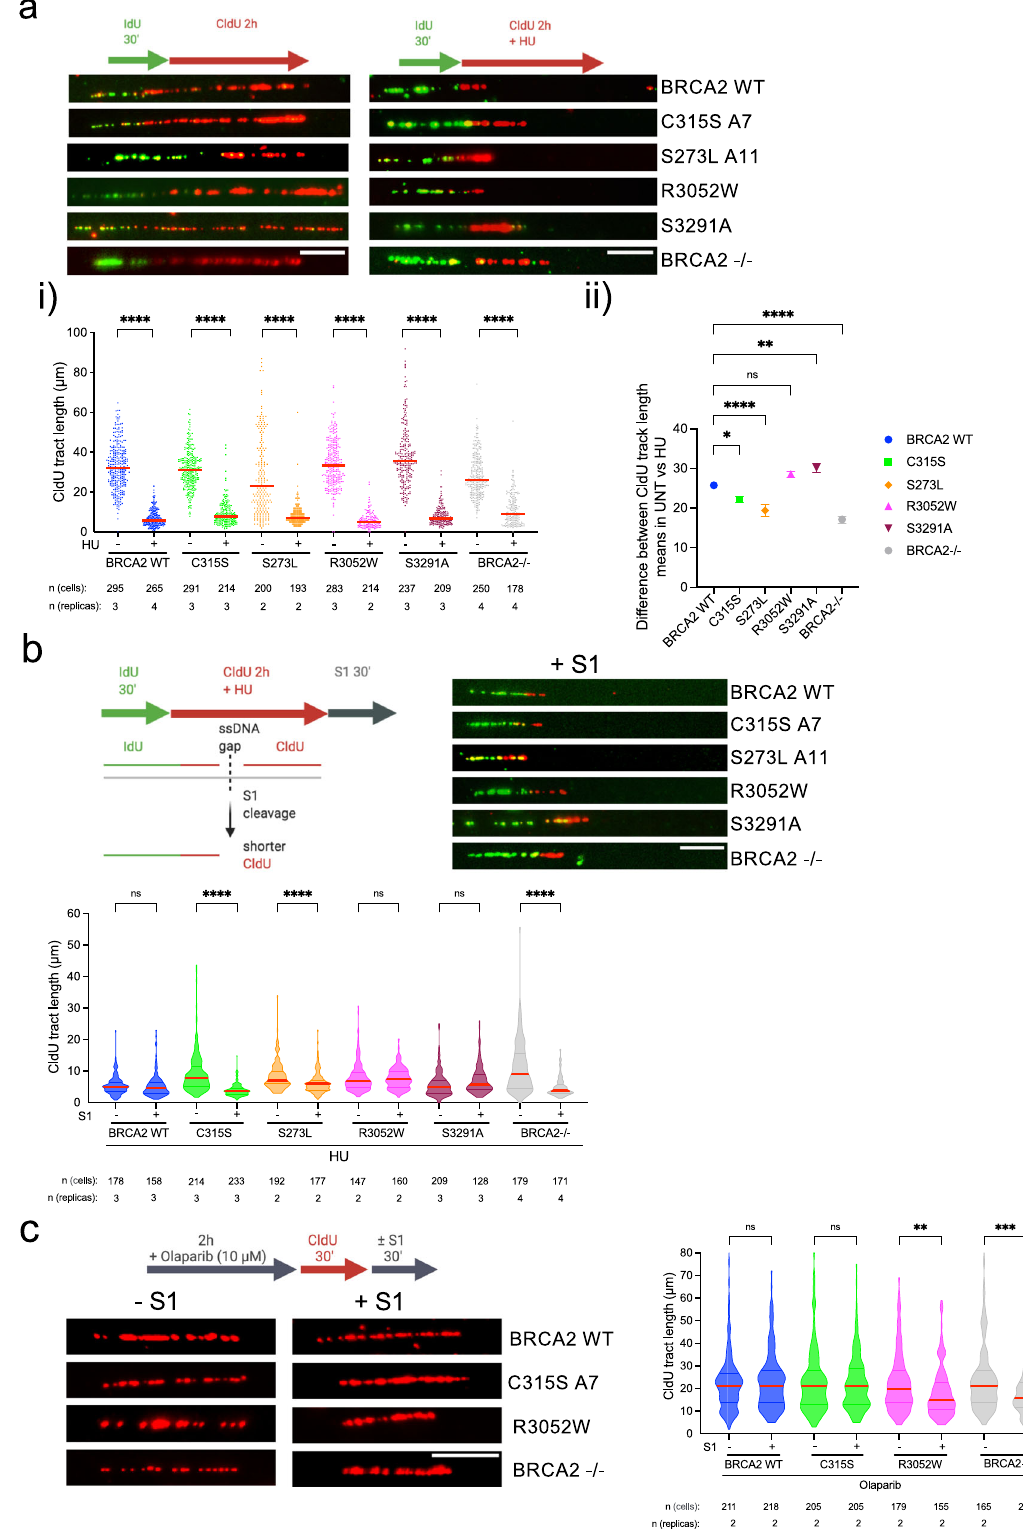
BRCA2-de fi cientcellsdisplayedonlyasmallreductionintheactivation of ATR/CHK1 compared to BRCA2 WT cells as detected by the levels